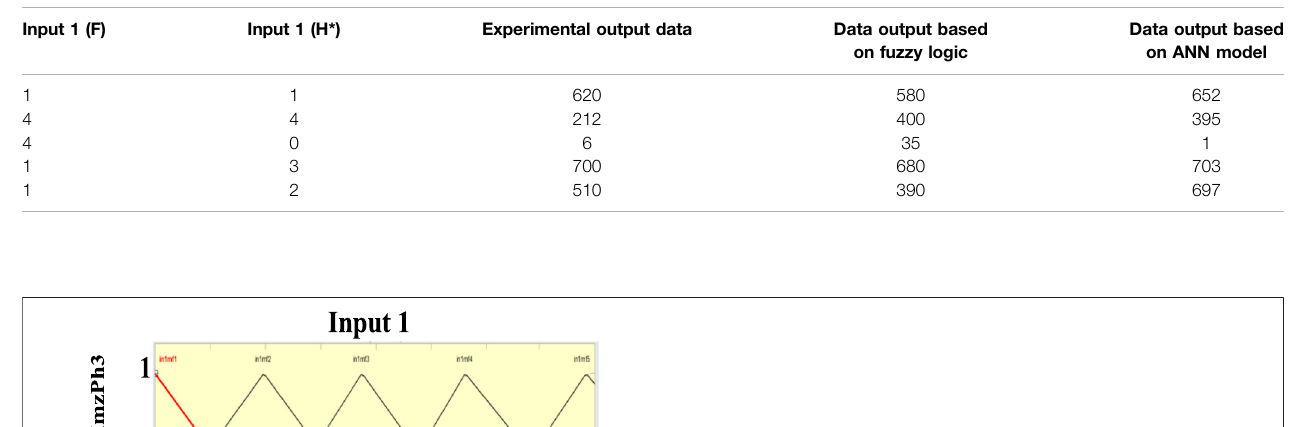
TABLE 1 | Experimental, fuzzy, and ANN model data in the presence of different input combinations.